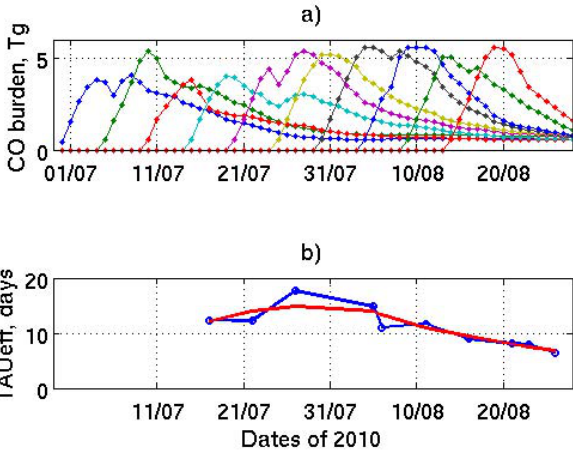
Fig. 13. (a) Simulated pyrogenic CO burden B over Russia in 2010 for 5-days-long idealized fires emitted 1.11Tgday − 1 for 10 cases; 1st case is for 1–5 July, 2nd for 6–10 July, etc. (b) Effective time pa- rameter TAU trans for the exponential decay of CO burden after the termination of simulated fire. Each point is averaged over periods of 12–16 days long. The red line is a smoothing approximation.